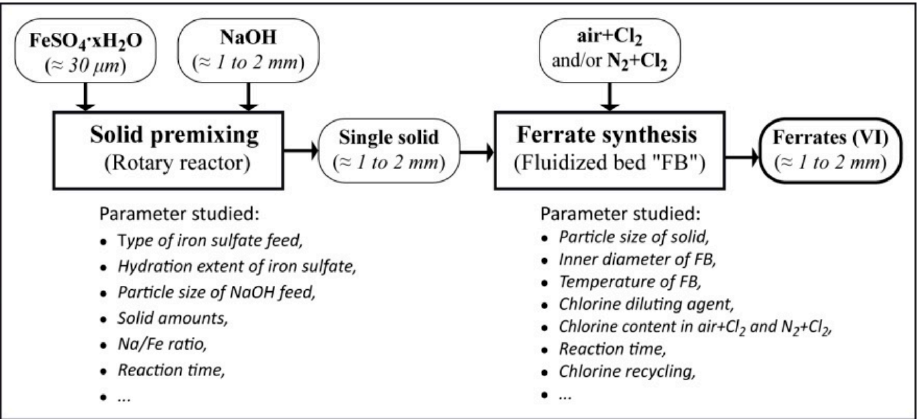
Figure 2. Schematic representation of ferrate production (extracted from [30]).